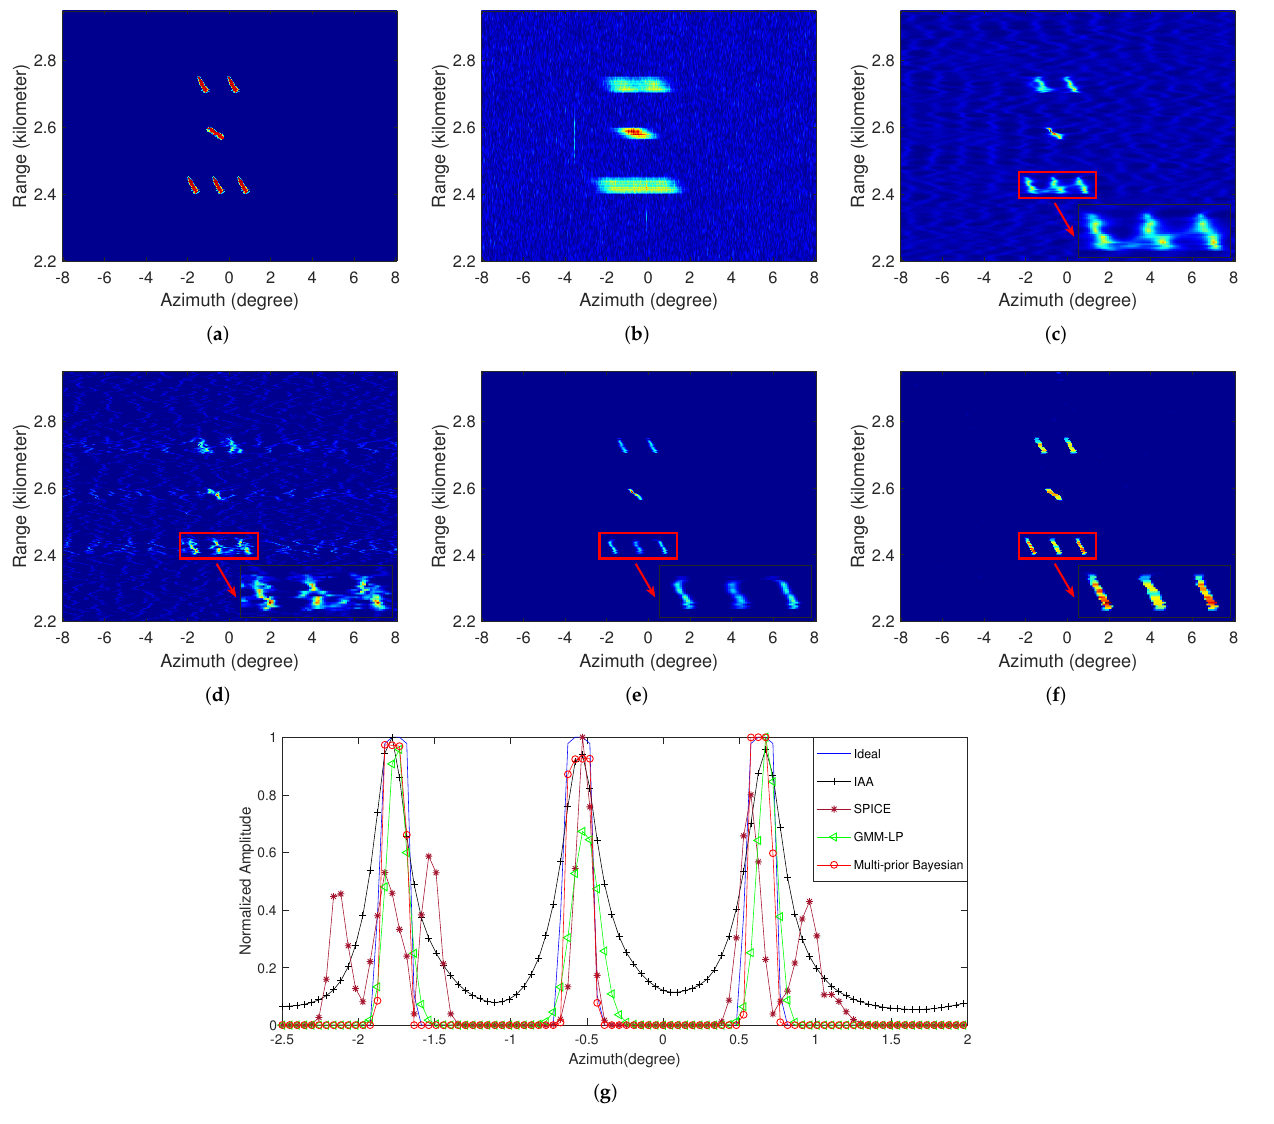
Figure 10. Results of semi-real data. ( a ) Ideal scene. ( b ) Echo signal. ( c ) IAA method. ( d ) SPICE method. ( e ) GMM-LP method. ( f ) Multi-prior Bayesian method. ( g ) Comparison at range cell 2435